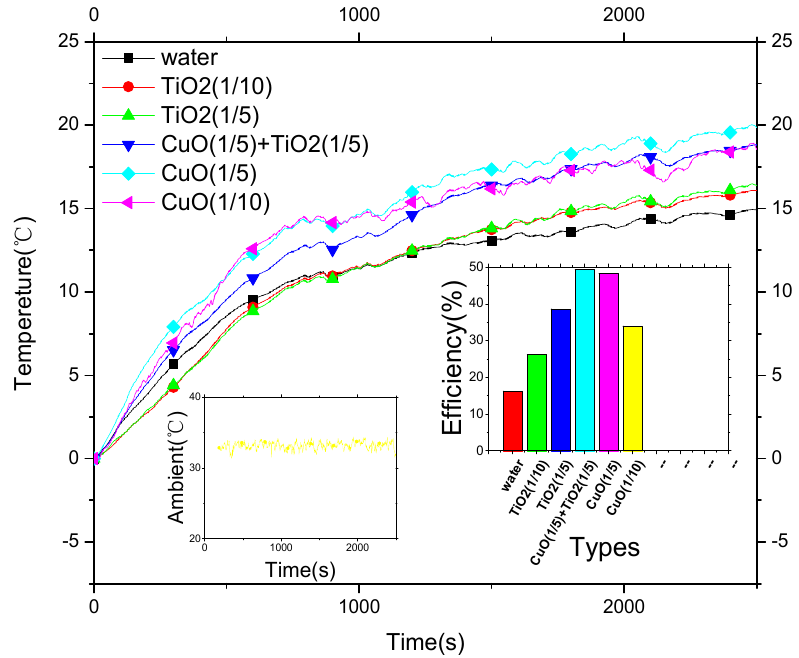
Figure 19. Predicted solar energy absorption efficiency and experimental results of Au − TiO 2 hy- brid nanofluid.